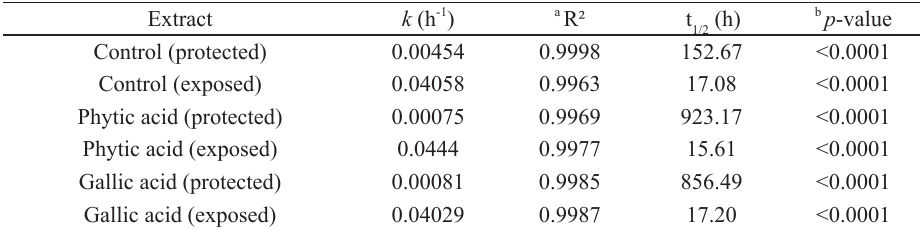
Effects of light and copigments on the first-order rate constant ( k ) and half-life time (t degradation of anthocyanins extracted from Ocimum basilicum L.